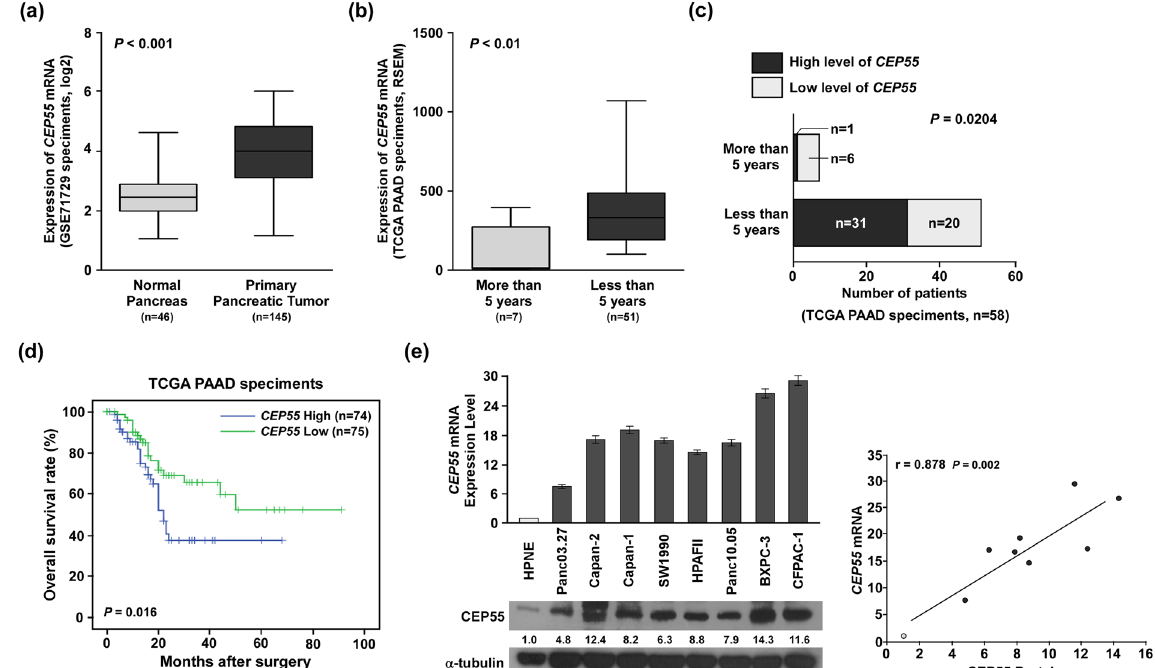
Figure 1. Expression levels of CEP55 mRNA correlated inversely with overall survival in patients with pancreatic cancer. ( a ) Quantification analyses of CEP55 mRNA expression between 46 normal pancreas tissues and 145 primary pancreatic tumour specimens from the Oncomine database (GSE71729 specimens). ( b ) Quantification analyses of CEP55 mRNA expression between seven pancreatic cancer (PANC) specimens with more than 5-year survival and 51 PANC specimens with less than 5-year survival from the TCGA database. ( c ) Statistical correlation between the CEP55 level and 5-year survival rates in patients with PANC. ( d ) Kaplan- Meier analysis showing associations of overall survival with relatively high and low expressions of CEP55 mRNA. ( e ) Quantitative real-time reverse transcription-PCR (qRT-PCR) and western blotting detection of CEP55 mRNA and protein in normal human pancreatic nestin expressing cells (HPNE) and cultured pancreatic cancer cell lines (Panc 03.27, Capan-1, Capan-2, SW1990, HPAF-II, Panc 10.05, BxPC-3, and CFPAC-1) (left panel). The Spearman correlation coefficient was calculated to assess the significance of the association between CEP55 mRNA and its protein expression levels (right panel). * P < 0.05, ** P < 0.01, *** P <